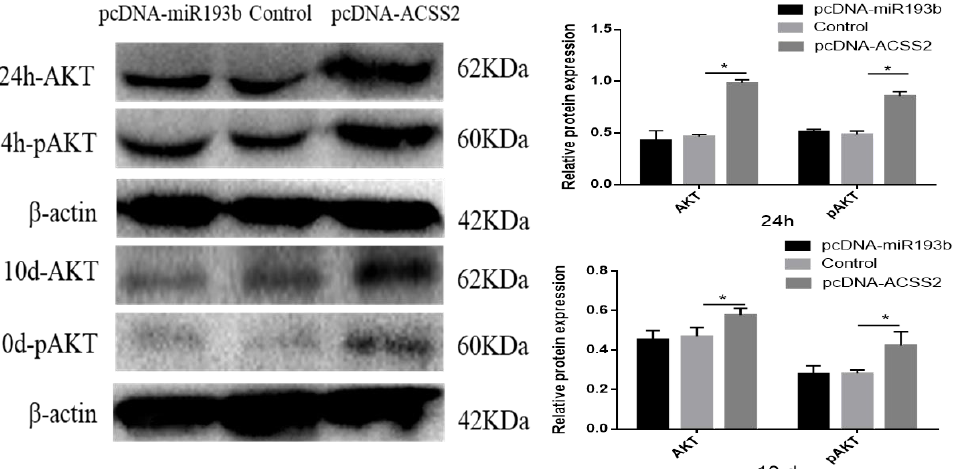
Figure 7. Bovine adipose cells transfected with pcDNA-miR-193b or pcDNA-ACSS2, AKT/pAKT proteins were detected by Western blot analysis. Values are mean ± SD for three biological replicates.